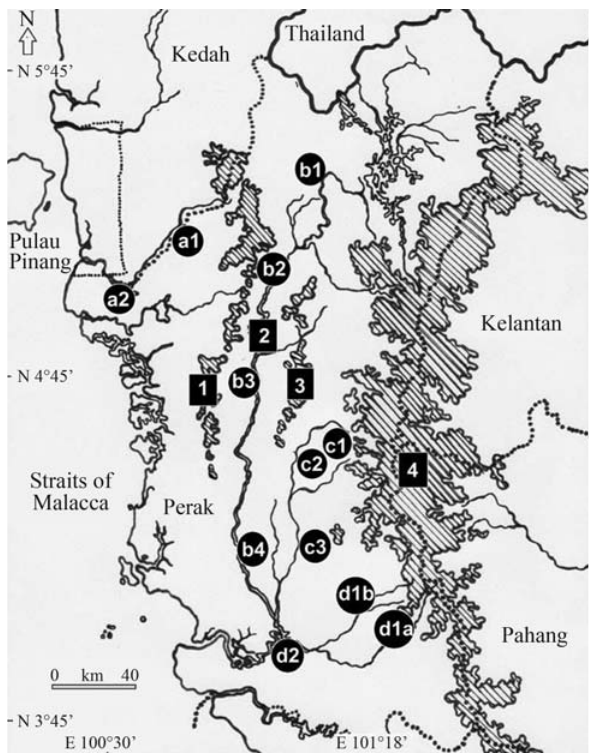
Figure 1 - Sampling locations of the twelve Channa striata populations analysed in the present study. Shaded areas represent mountain ranges and closed circles (alphabet) sampling sites, whereas the closed squares (num- ber) are significant geographical landmarks, present in the region. (1) Bintang mountain range, (2) Chenderoh dam, (3) Keledang mountain range and (4) Titiwangsa mountain